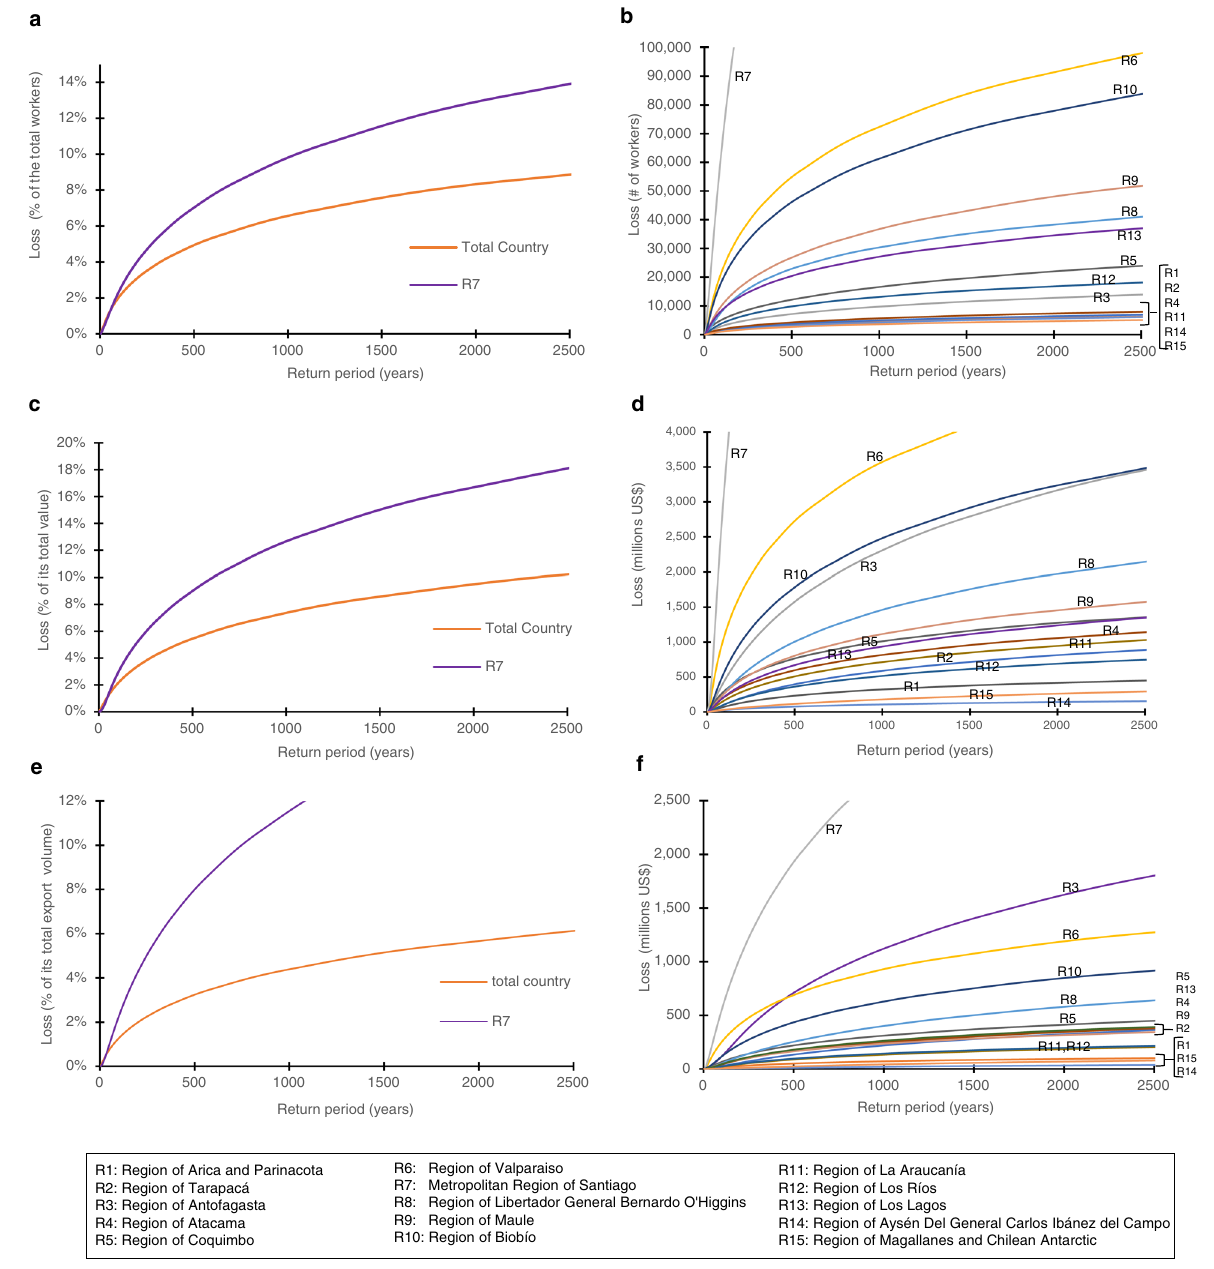
R11: Region of La Araucanía R12: Region of Los Ríos R8: Region of Libertador General Bernardo O'Higgins R13: Region of Los Lagos R9: Region of Maule R14: Region of Aysén Del General Carlos Ibánez del Campo R10: Region of Biobío R15: Region of Magallanes and Chilean Antarctic Fig. 5 Loss Exceedance Curves (LECs) for Chile of employment, Gross Domestic Product (GDP), Gross Region Product (GRP), and export volume. a Shows the loss exceedance curves of employment for the whole country and Region 7 (Metropolitan Region of Santiago). b Shows the employment loss exceedance curves for each region of Chile. c Illustrates the loss exceedance curves of GDP for Chile and the loss exceedance curve of GRP for Region 7. d Illustrates the GRP loss exceedance curves for each region of Chile. e Shows the loss exceedance curves of export volume for the whole country and Region 7. f Shows the loss exceedance curves of export volume for each region of